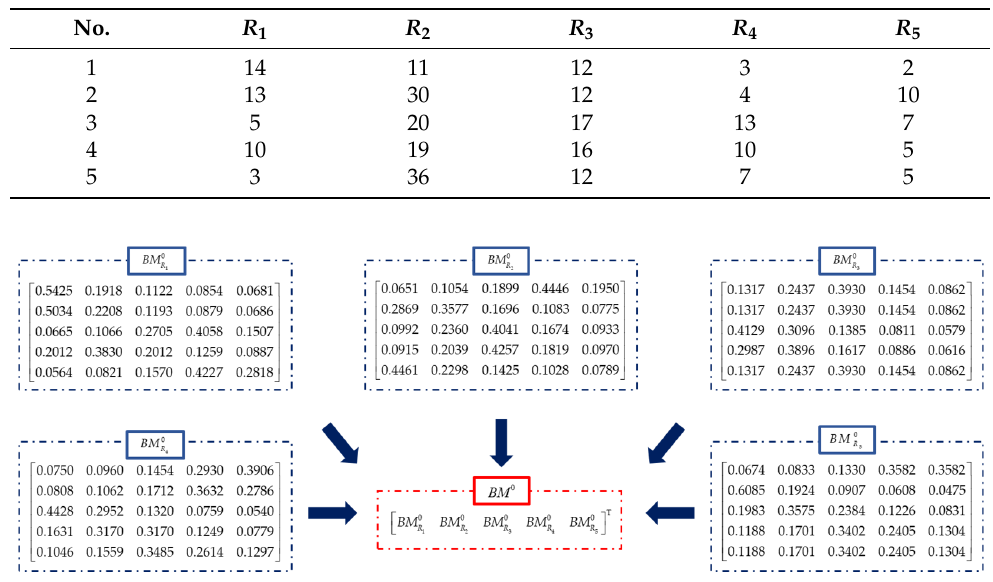
Table 3. Data of rock mass for model validation.